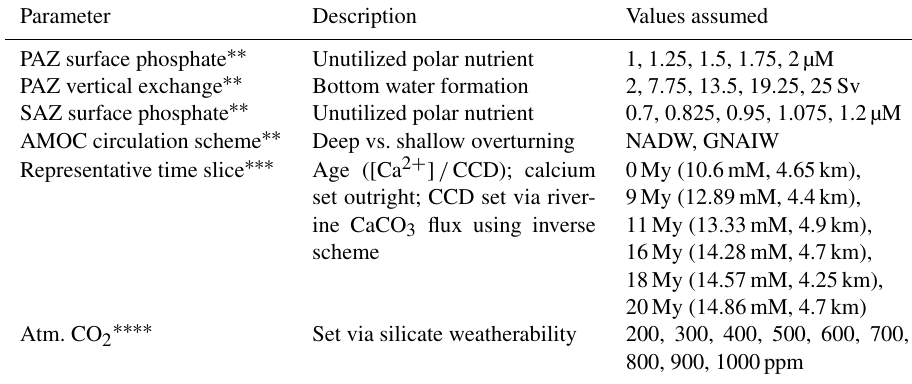
Table 1. CYCLOPS model parameter values defining the ensemble of 13500 simulations ∗ .